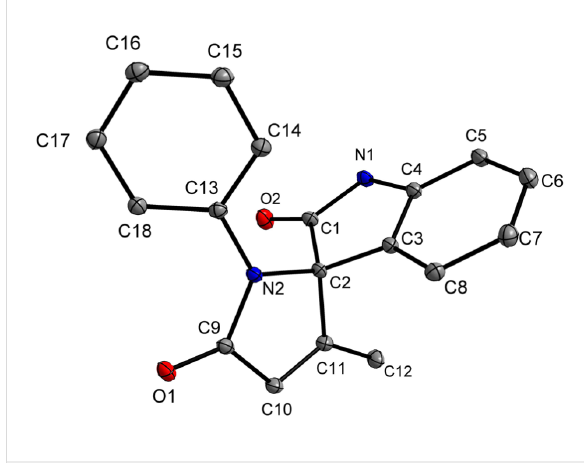
Figure 1: ORTEP diagram of compound 7a